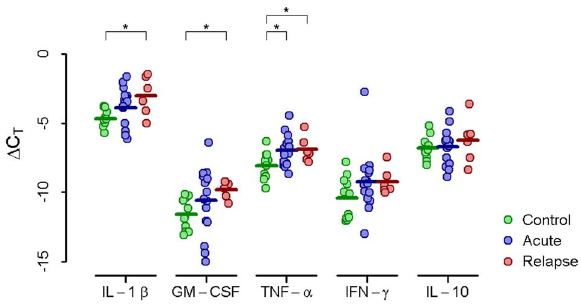
Figure 1. Basal PBMC cytokine gene expression. Relative basal amounts of IL-1 b , GM-CSF, TNF- a , IFN- c , and IL-10 mRNA compared to the housekeeping gene GAPDH ( D C T ) in unstimulated PBMCs from control donors or acute or relapse brucellosis patients (asterisk indicates